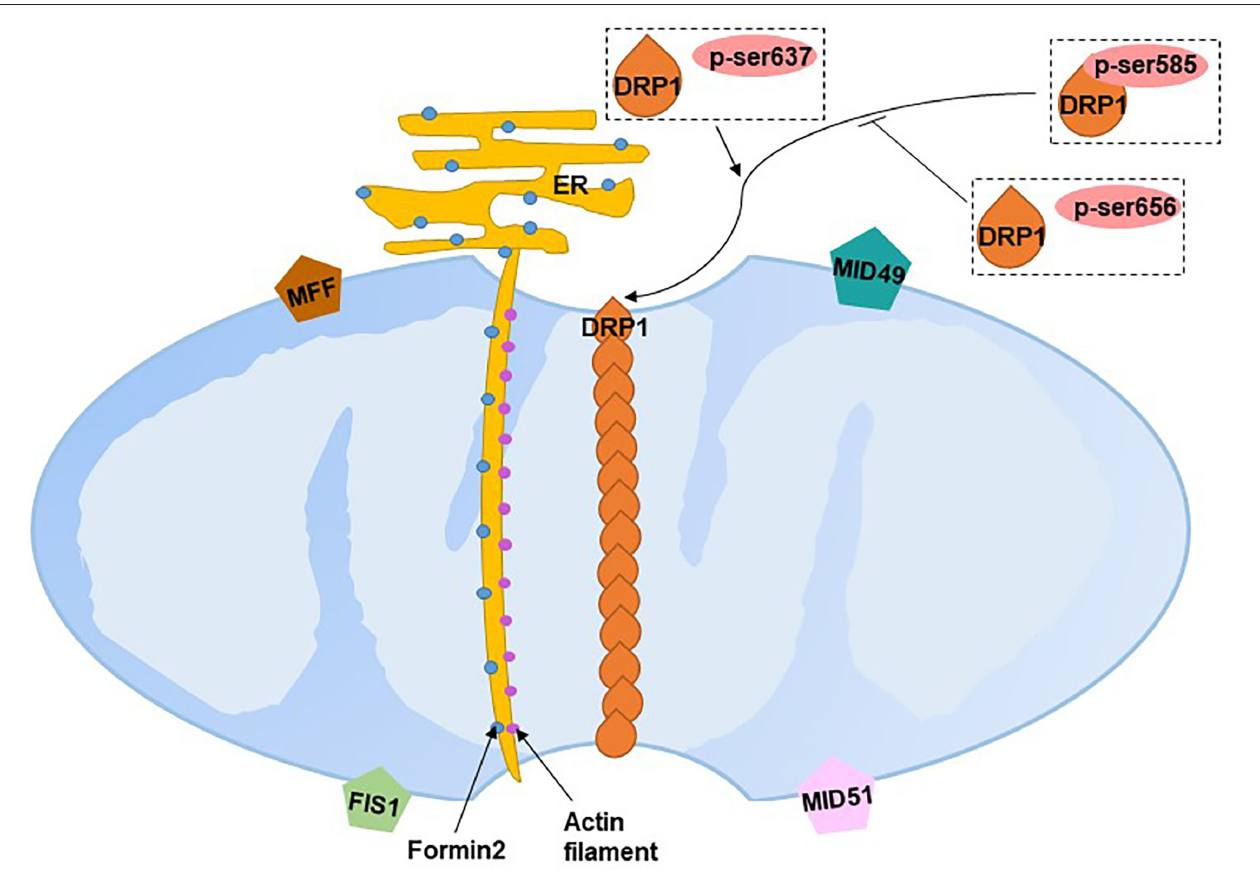
FIGURE 6 | Mitochondrial fission. ER, endoplasmic reticulum; DRP1, dynamin-related protein 1; FIS1, fission 1; MFF, mitochondrial fission factor; MID49, mitochondrial dynamics protein of 49 kDa; MID51, mitochondrial dynamics protein of 51 kDa. Blue dots on the ER refer to formin 2, purple dots between the mitochondria and endoplasmic reticulum refer to actin